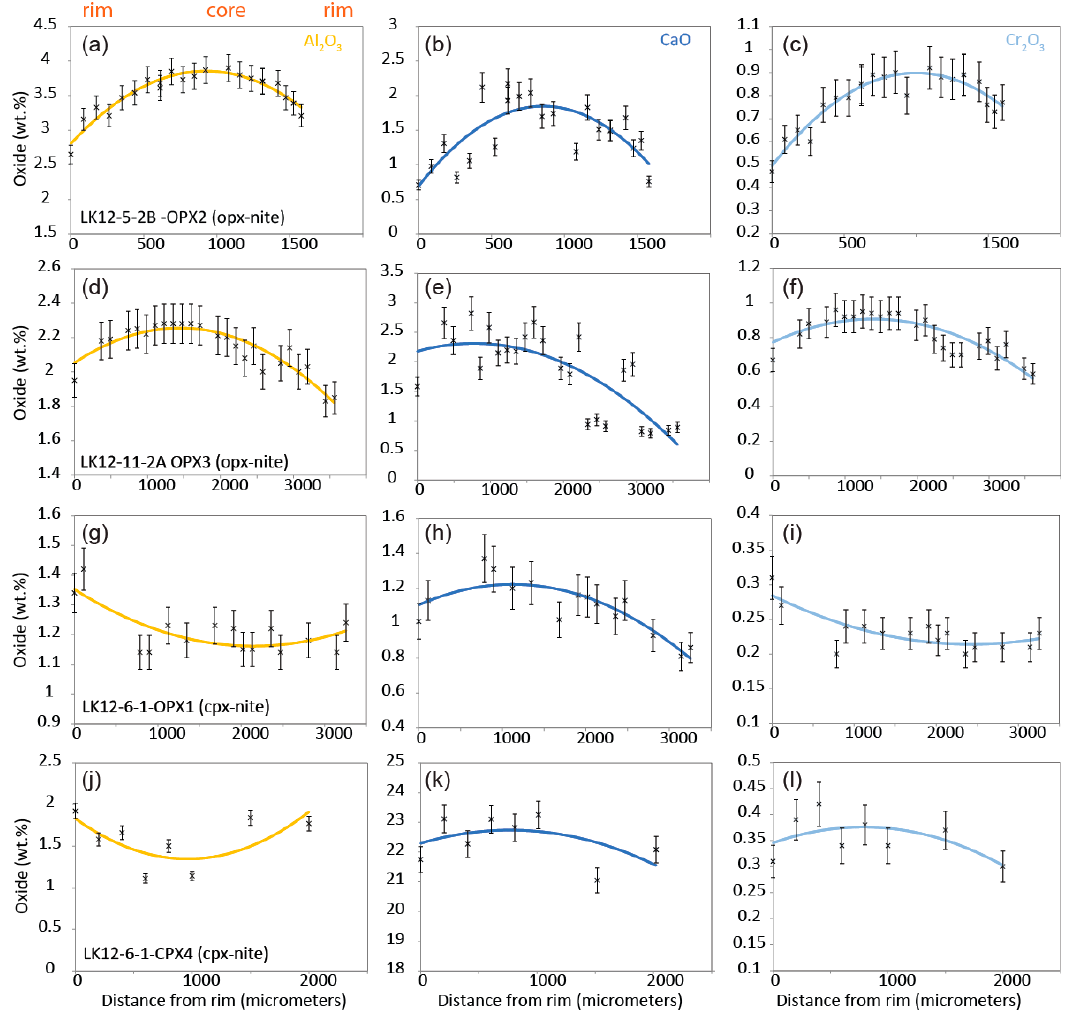
Figure 5. Al 2 O 3 , CaO, and Cr 2 O 3 concentrations (wt.%) along with rim-to-rim profiles in OPX